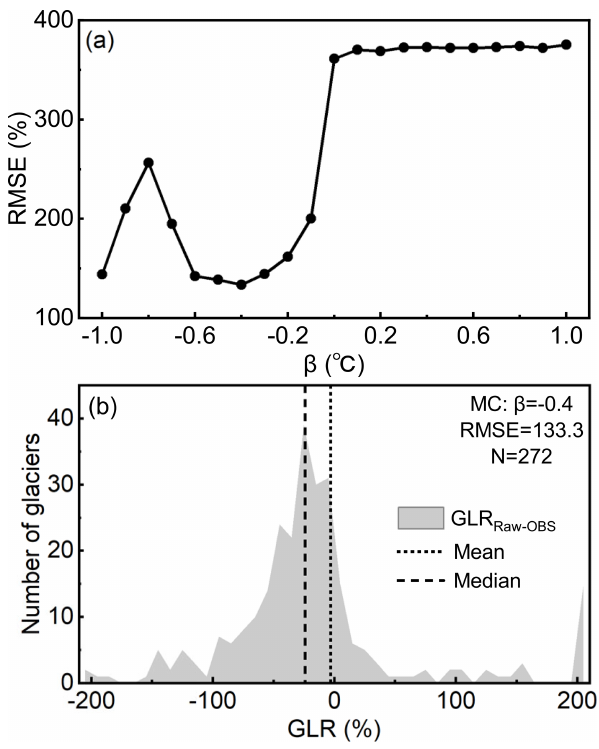
Figure 3. (a) The RMSE of maximum peak GLR between the raw simulation results and mapped LIA glaciers for the MC experiment with various β . (b) The simulation bias distribution of maximum peak GLR for the MC experiment with β = − 0 .